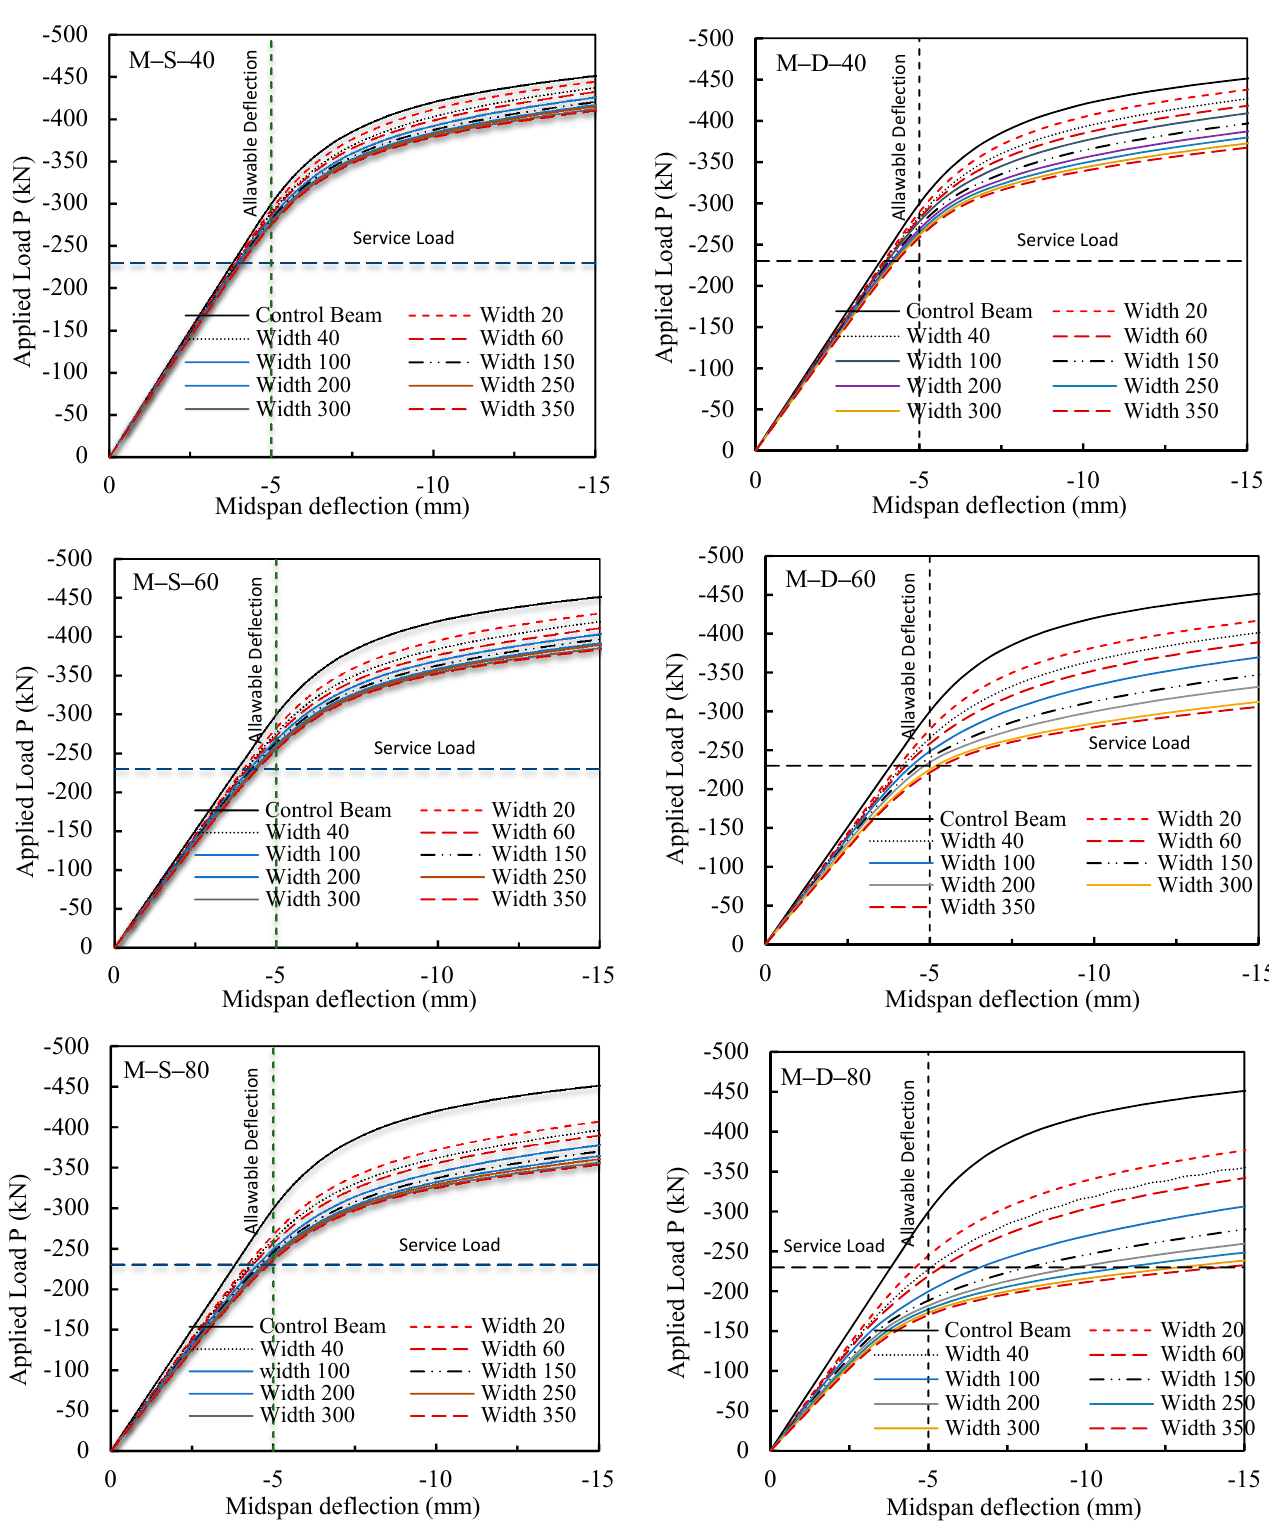
Figure 11. Numerical applied load–midspan deflection relations. Figure 11 indicates that when the depth of the notch increased, the load-carrying ca- pacity of the beams was significantly affected. This can be explained by the observation that when the notch depth increased, the notch damage got closer to the beam web and, therefore, the stress concentration at the end of the notch became within the vicinity of the beam web, leading to an increase in the web strains and stresses. The increase in the web strain and stress led to a decrease in the beam stiffness and capacity and to an increase in the defection rate. This analysis is clearly confirmed by Figures 12 and 13, where for M-S and M-D beams with notch depths of 80 mm, the stresses and strains were concentrated and high not only in the beam flange but also in the beam web, due to the nearby notch. On the other hand, as the width of the notch increased, these high stresses and strains spread, affecting a larger area of the web, as revealed in Figures 12 and 13, and caused a wider portion of the beam to yield. As a result, the stiffness of the beam decreased, the beam capacity decreased, and the beam deflection rate increased rapidly, which acceler- ated the occurrence of permanent deformations. The figures show that the damage af- fected the stiffness of the beams, resulting in an increase in deflections at design loads. This impact of the damage on the steel beam deflection should be addressed in design codes for serviceability requirements.